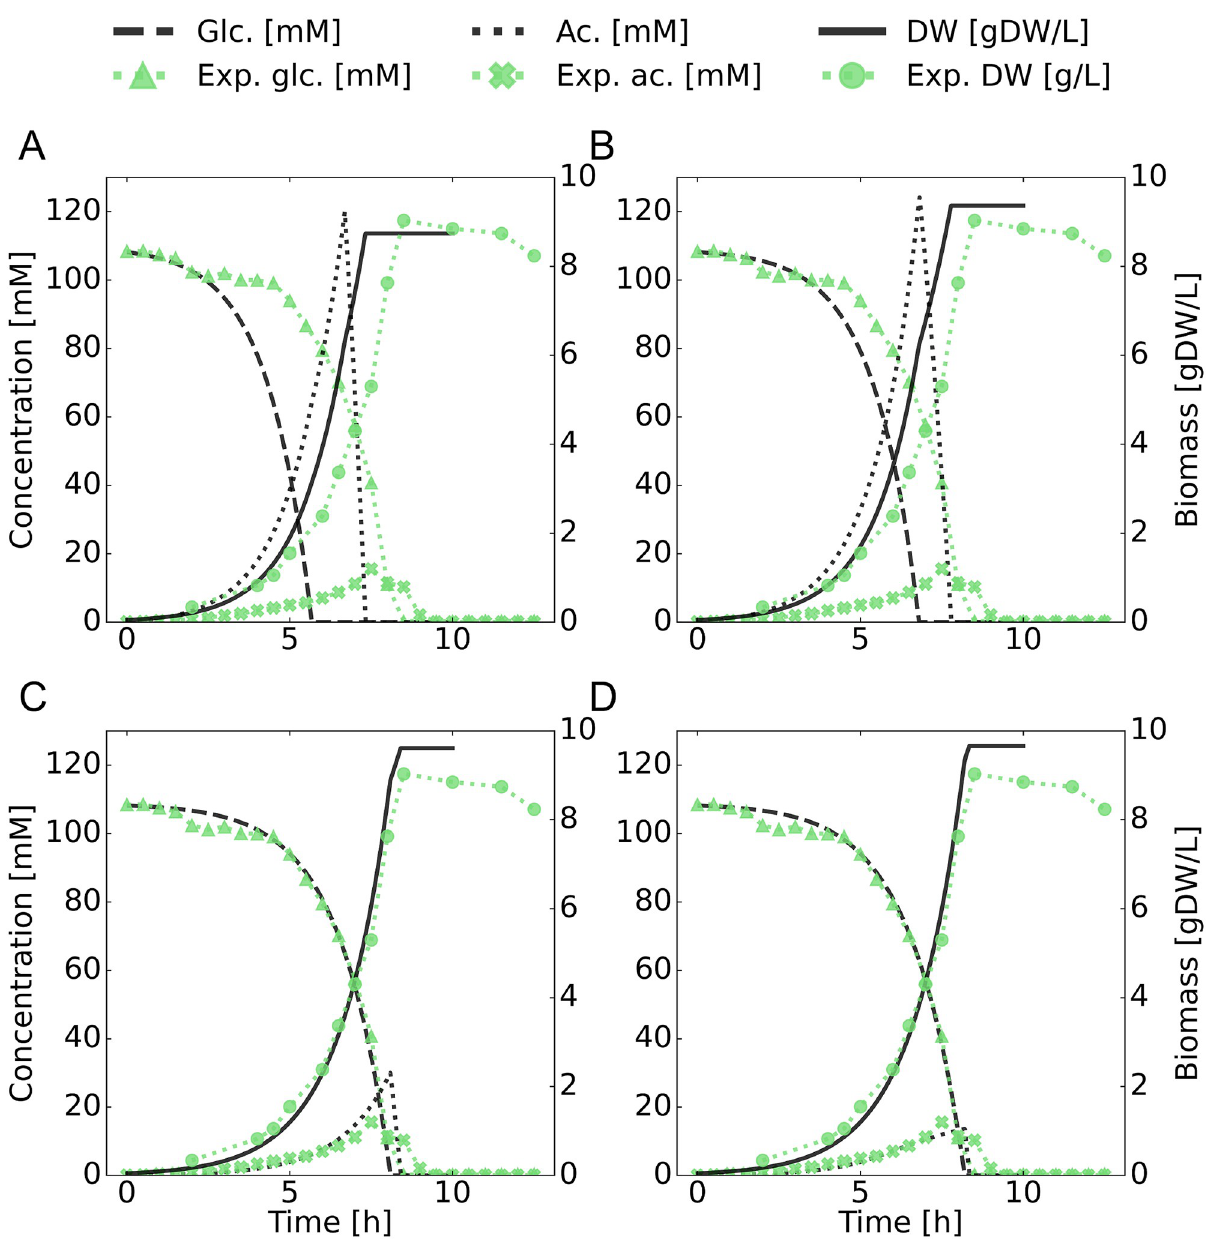
Fig 2. Model parameter adjustment. Shown in the figure are glucose (glc), acetate (ac) and biomass (DW) concentrations for four snapshots of the model tuning process. It displays a comparison of modeling results with measurements throughout successive adjustments of base sMOMENT model parameters. As can be seen, several export reactions need to be blocked, and several rates limited in order to reproduce realistic behavior, even with the total enzyme pool constraints. The order and nature of adjustments are listed in Table 1. In short: panel A is i JO1366 out-of-the-box, panel B is oxygen uptake-limited with lactate and dihydroxyacetone export blocked. Panel C has acetate exchange bounded and pyruvate excretion blocked, while panel D has acetate excretion feedback